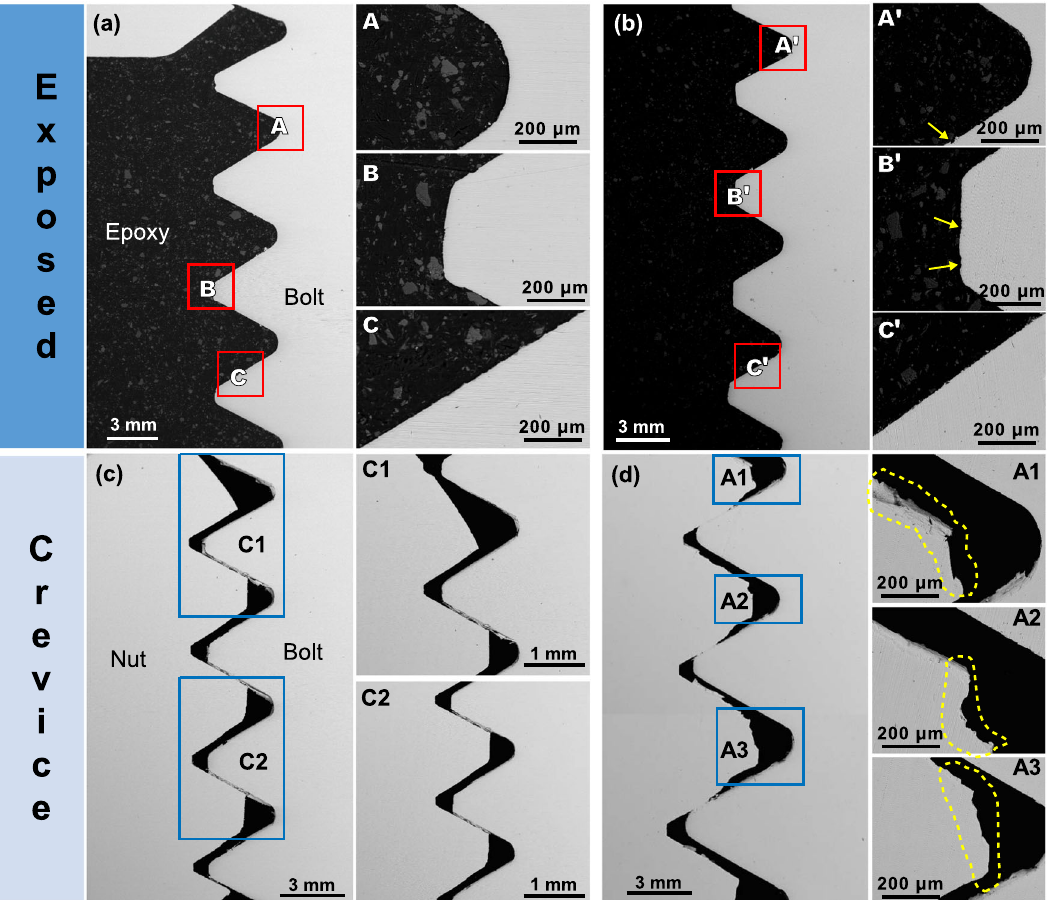
Fig. 2 Cross-sectional morphologies of the threaded surface of 304SS fastener before and after corrosion test for 30 days. a , b Exposed regions, and c , d crevice